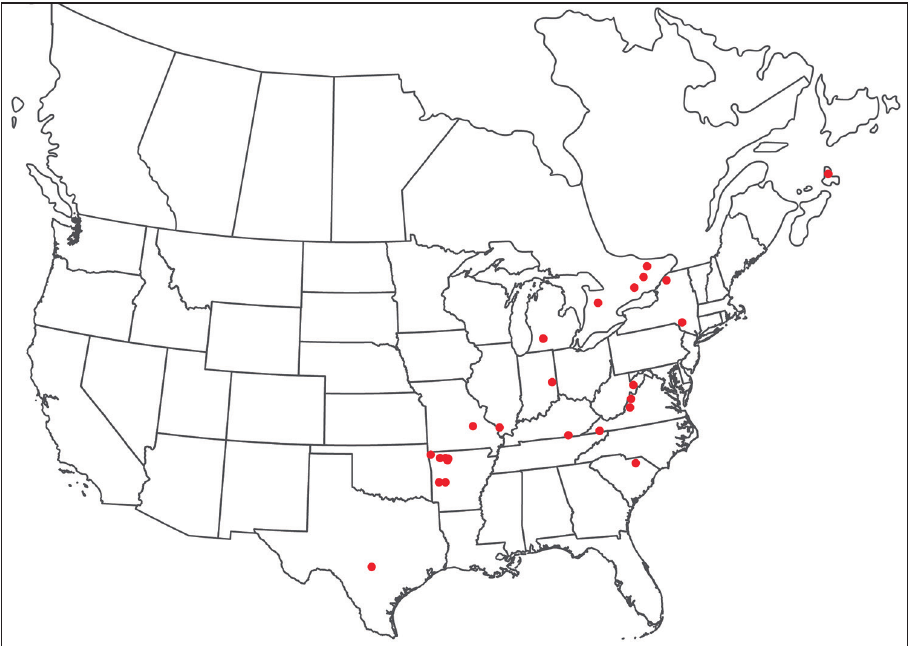
Figure 255. Torrenticola trimaculata